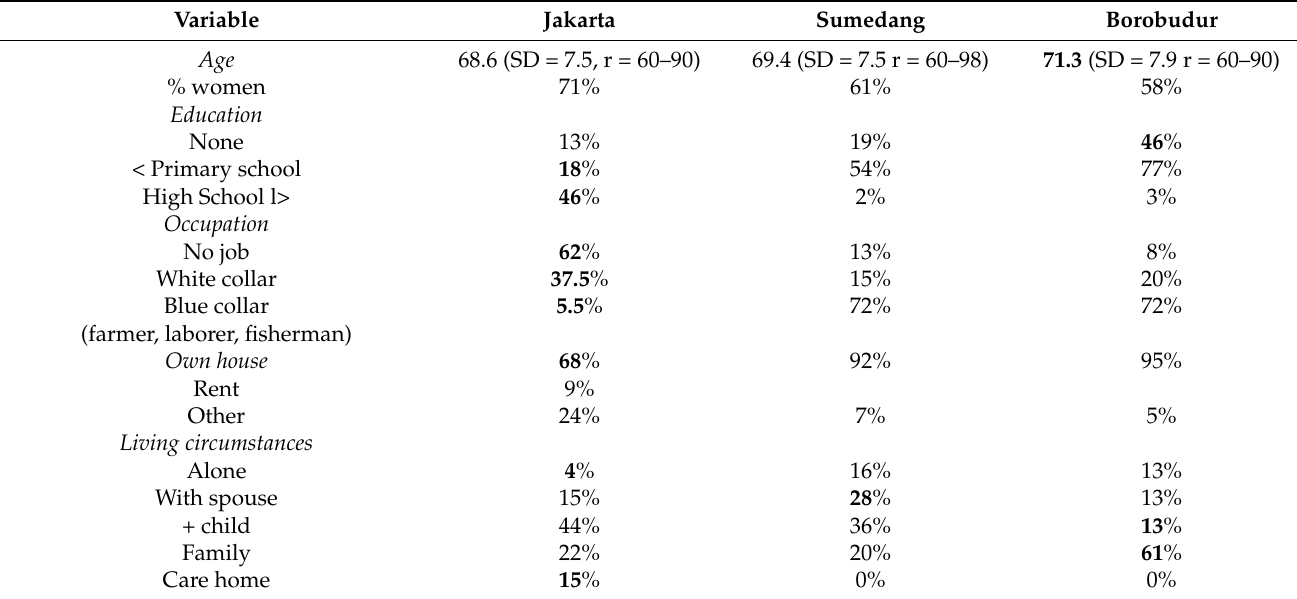
Table 2. Demographics in the different sites in participants over 60 years of age. Bold indicates differences by site (data given in percentages or means, SD = standard deviation, r = range).